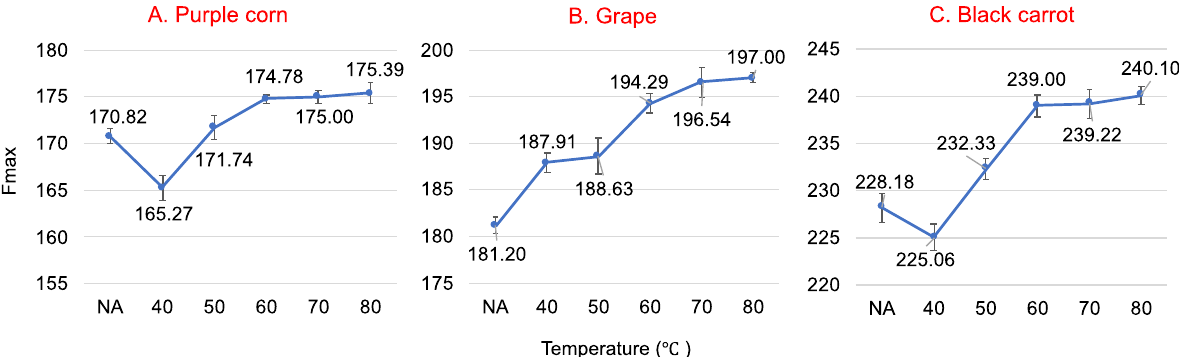
Figure 4. Fluorescence maximum intensity change of native and preheated whey protein (40 °C, 50 °C, 60 °C, 70 °C and 80 °C) at 25 °C in the presence of 50 µM purple corn ( A ), grape ( B ) and black carrot ( C ) anthocyanin-rich extracts at an excitation wavelength of 280 nm at pH 3.